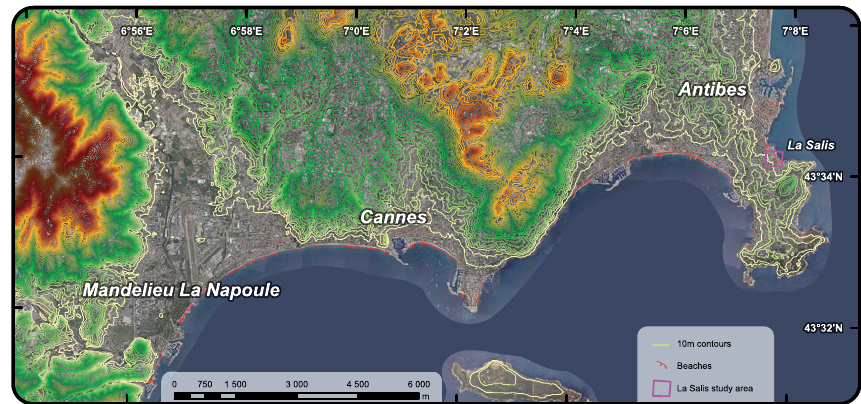
Fig. 2. Topographical context, beaches of the studied area and location of La Salis